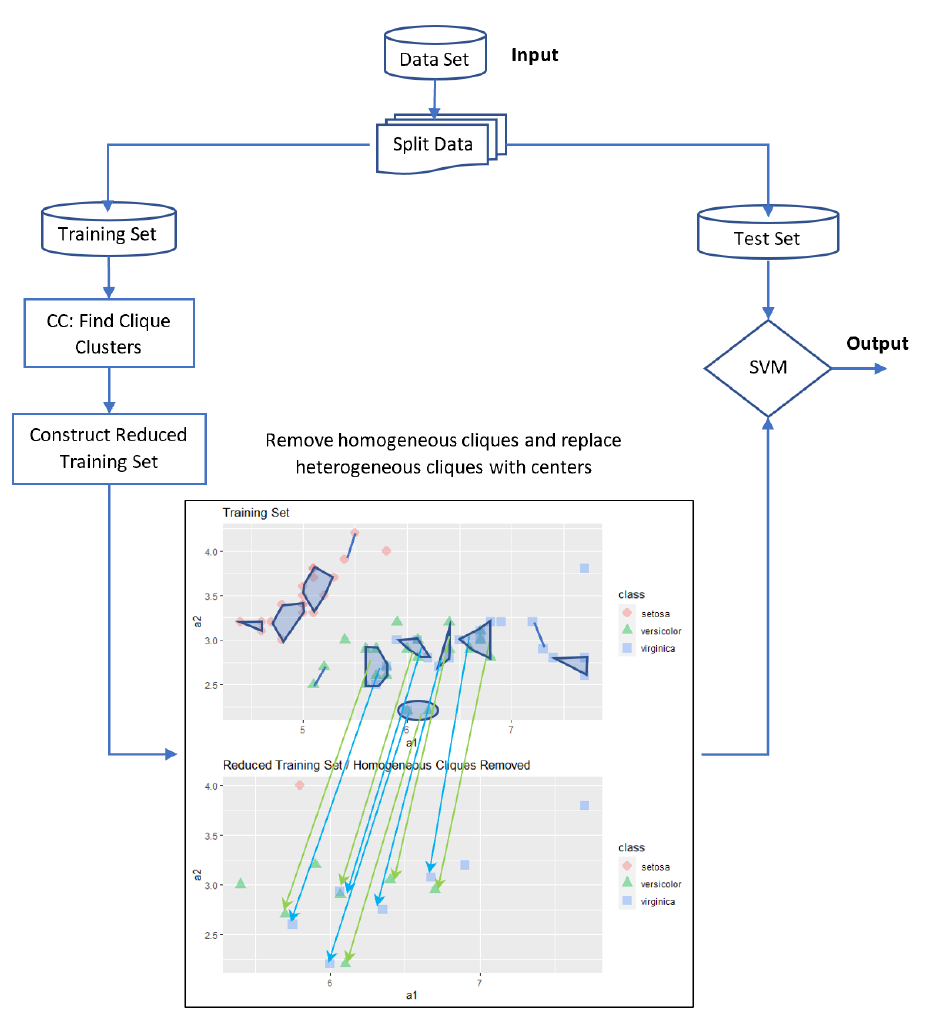
Figure 4. Flowchart of